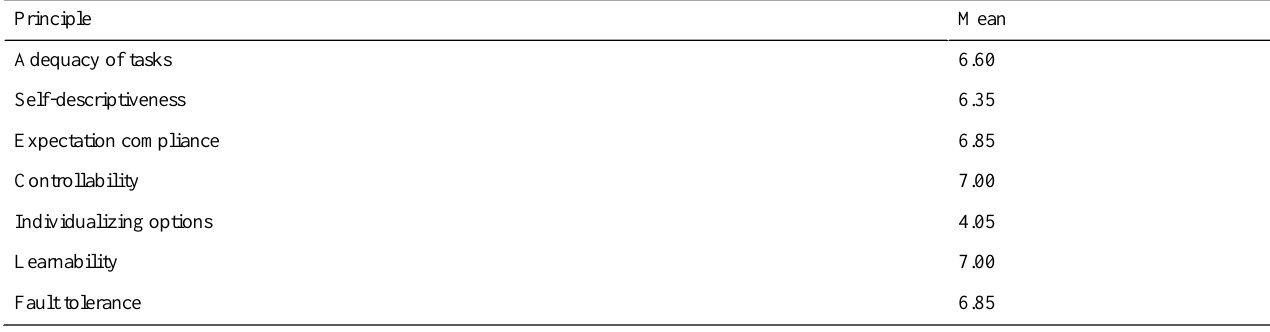
Table 3. Ergonomic principles for software